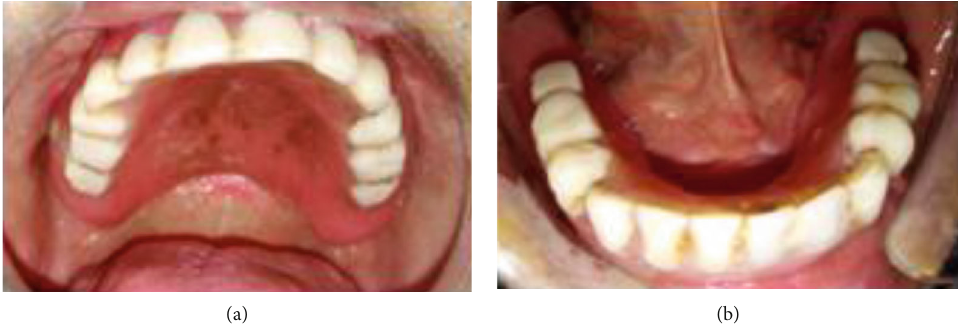
Figure 12: Prosthesis examination: (a) old maxillary prothesis and (b) old mandibular prosthesis.